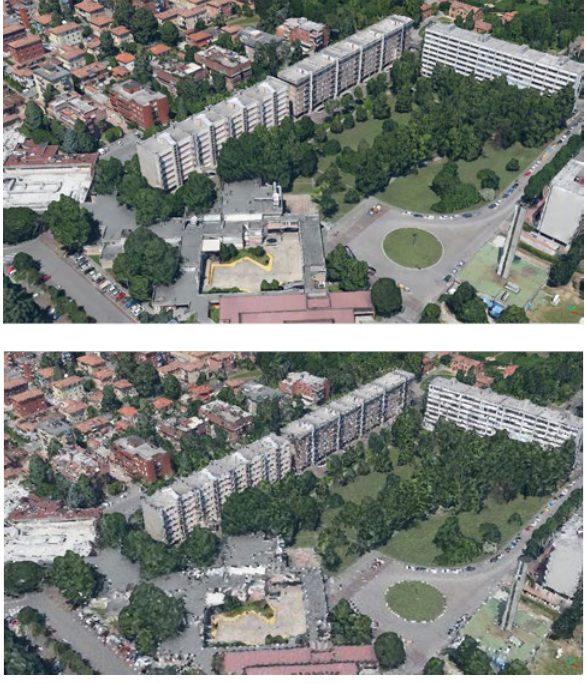
Figure 4. A detail of the obtained 3D model. Top: by ContextCapture, bottom: by